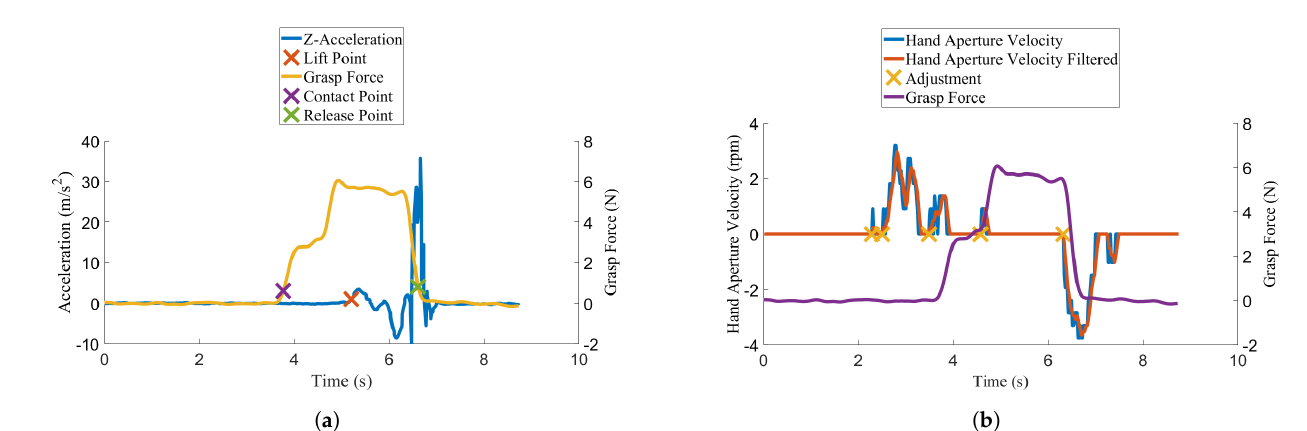
Figure 9. Outcome measure extraction ( a ) contact point, lift point, and release point ( b )